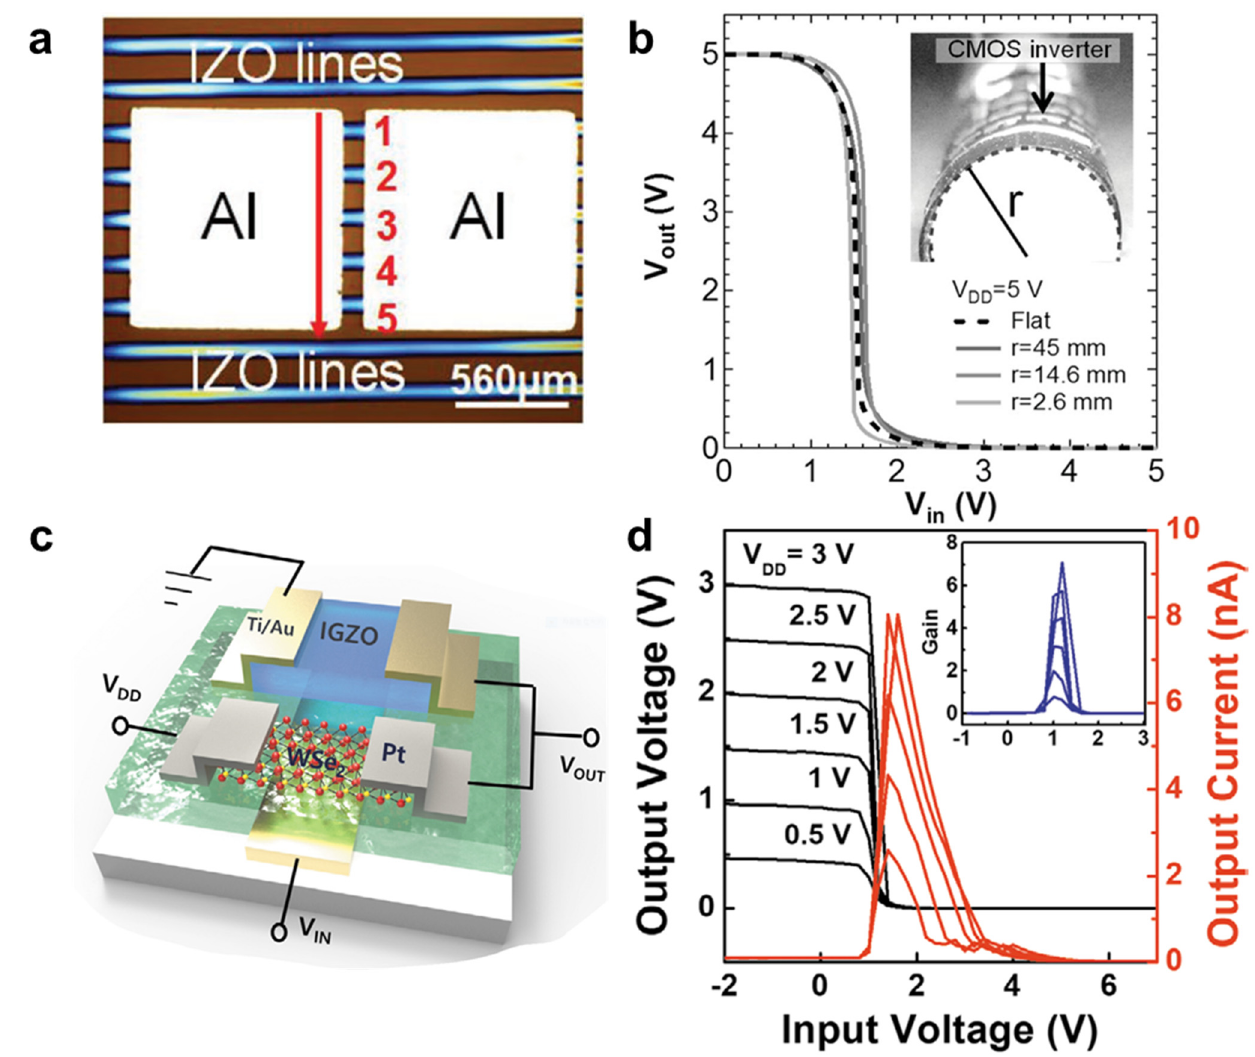
Figure 2. ( a ) Top view OM image of an IGZO TFT fabricated with an inkjet printing method (adapted from [80] with permission from John Wiley and Sons). ( b ) Output voltage characteristics of a 3D CMOS inverter allowing a bending radius up to 2.6 mm (adapted from [83] with permission from John Wiley and Sons). ( c ) A 3D illustration of a CMOS inverter consisting of p- WSe 2 and n- IGZO FETs fabricated on a glass substrate. ( d ) Voltage transfer characteristic curves (black) with voltage gain (inset) and output current (red) of proposed CMOS inverter as obtained from 0.5 to 3 V of V DD (adapted from [84] with permission from John Wiley and Sons).